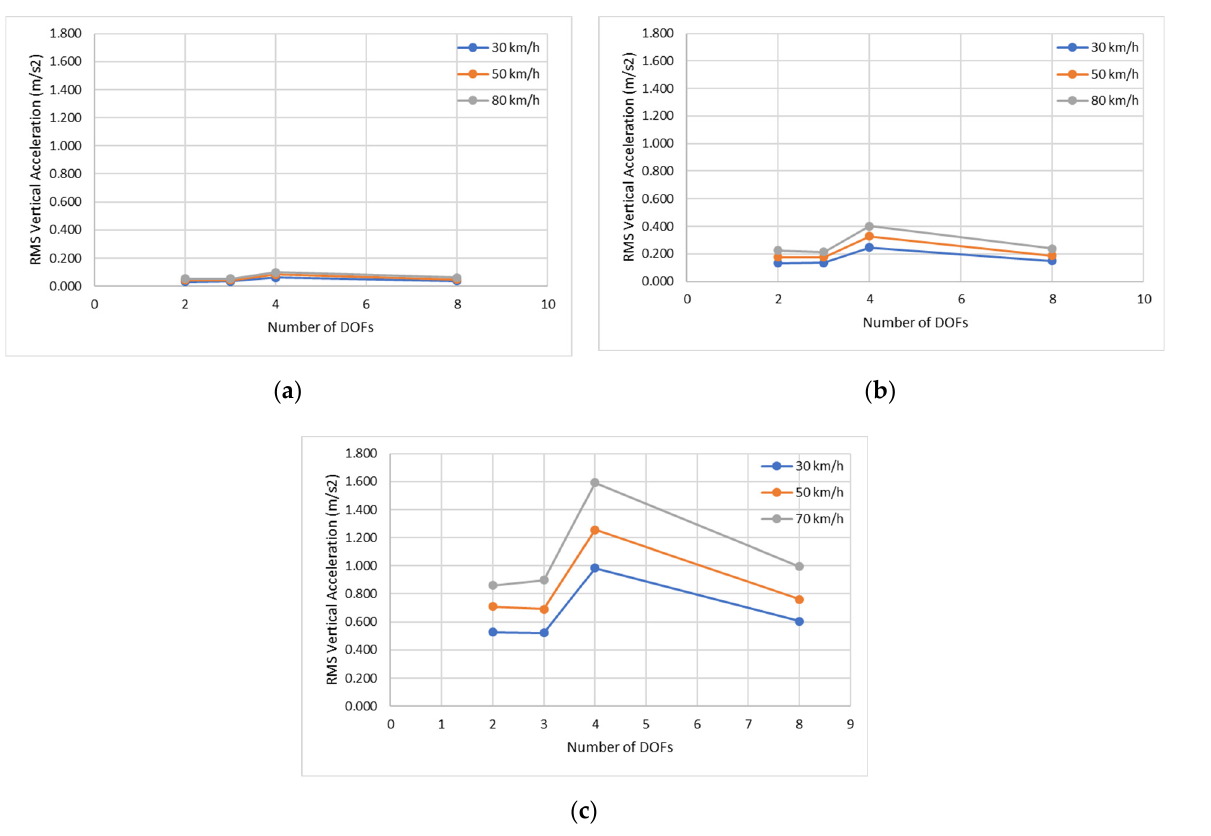
Table 11. The CPU time for all the VSH models in Class A, C and E road profiles.